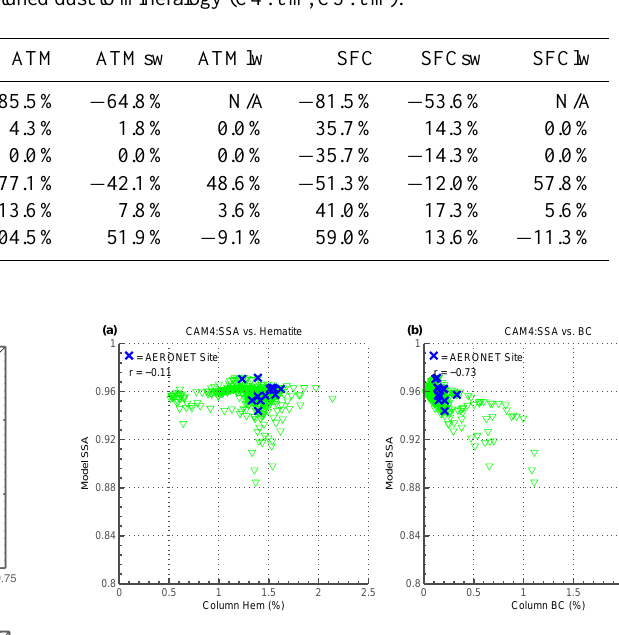
Figure 10. Model single scattering albedo at grid cells with AOD dust >0.5 · AOD total in CAM4 mineralogy is compared to total percent column hematite (a) and total percent column black car- bon (b) . The locations of AERONET sites used in the comparison in Fig. 9 are plotted in blue.